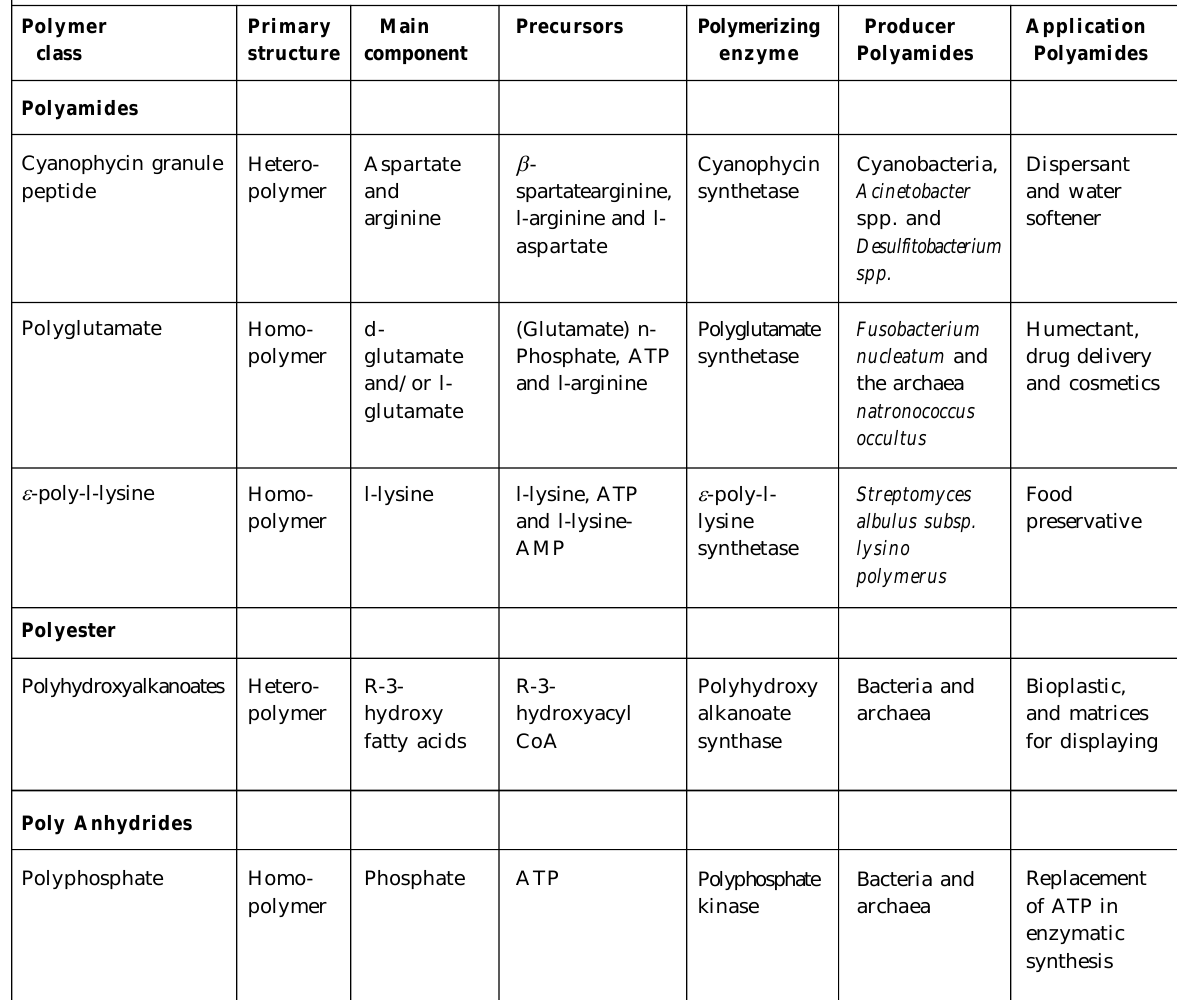
Table 1: Classes of bacterial polymers and their characteristics, Adapted from Rehm,